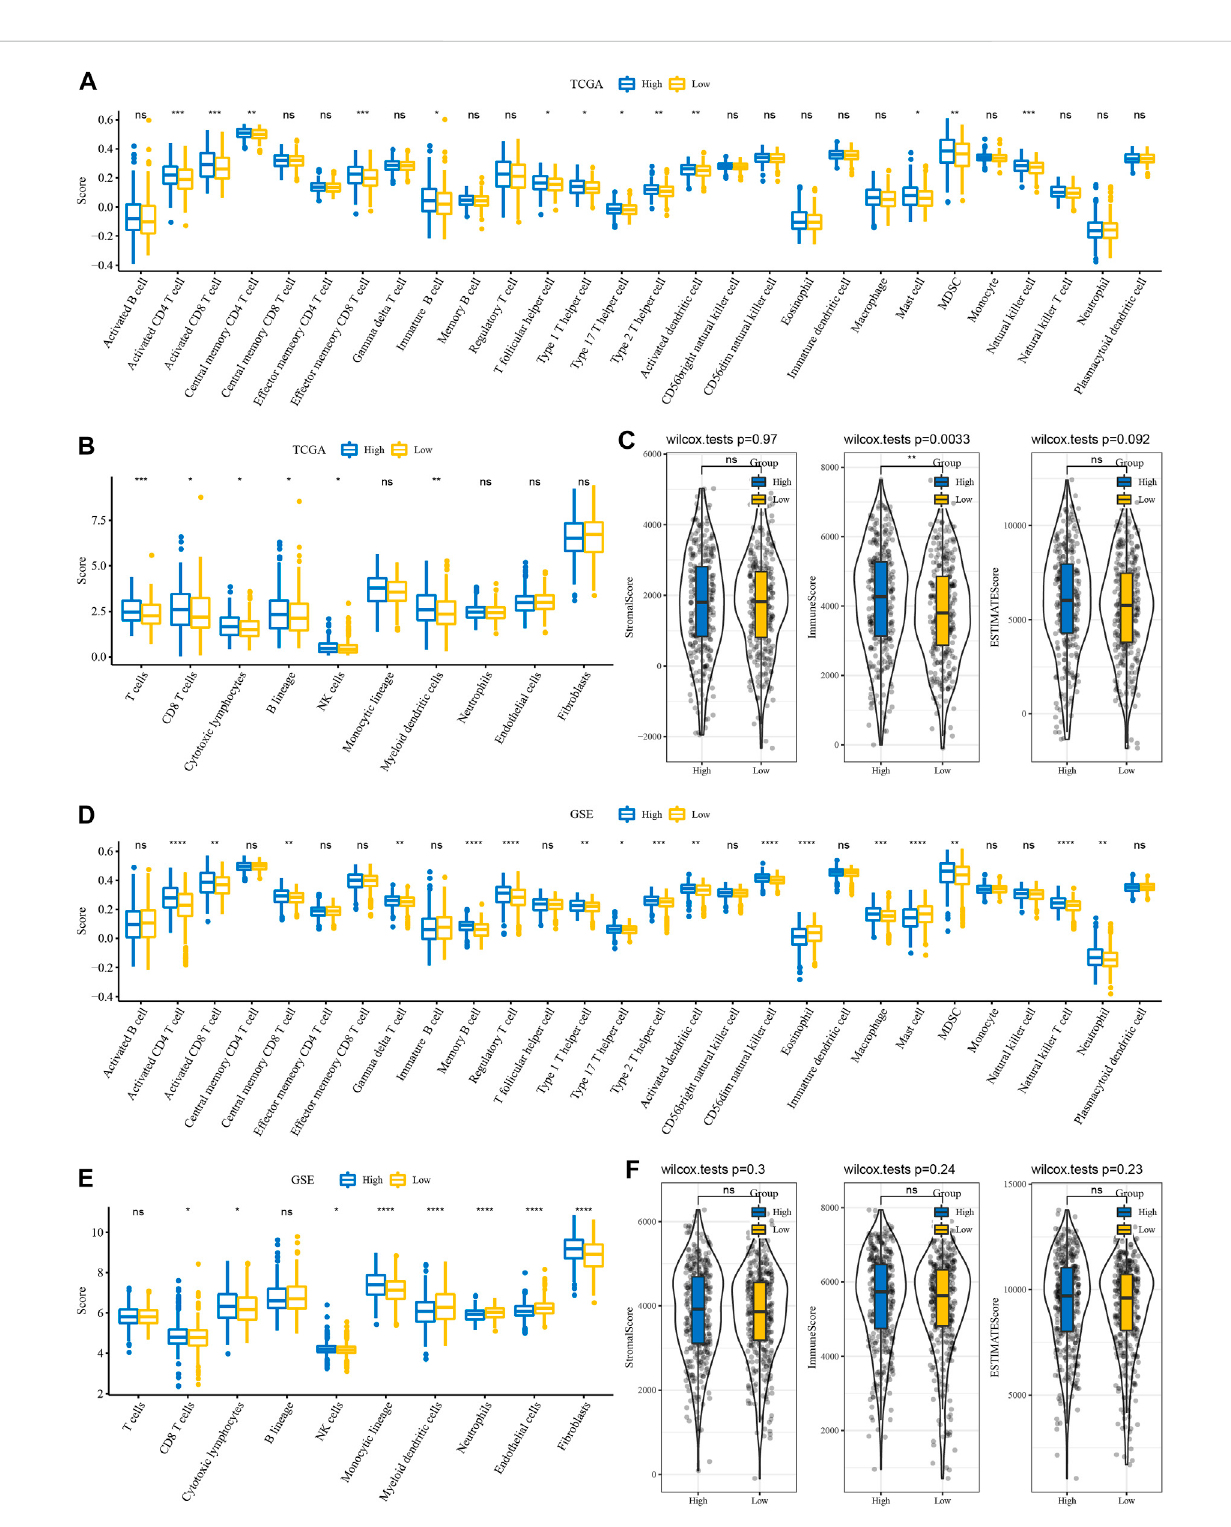
FIGURE 5 Immune features between RiskScore groupings. (A) ssGSEA evaluated the subtypes of 28 immune cell scores in TCGA cohort. (B) MCP-counter evaluated subtype comparison of 10 immune cell scores in TCGA cohort. (C) ESTIMATE subtype comparison of StromalScore, ImmuneScore, and ESTIMATEScore in TCGA cohort. (D) Subtype comparison of 28 immune cell scores assessed in the GSE cohort with ssGSEA. (E) Subtype comparison of 10immunecellscoresassessedintheGSEcohortwithMCP-counter. (F) SubtypecomparisonofStromalScore,ImmuneScore,andESTIMATEScore in the GSE cohort with